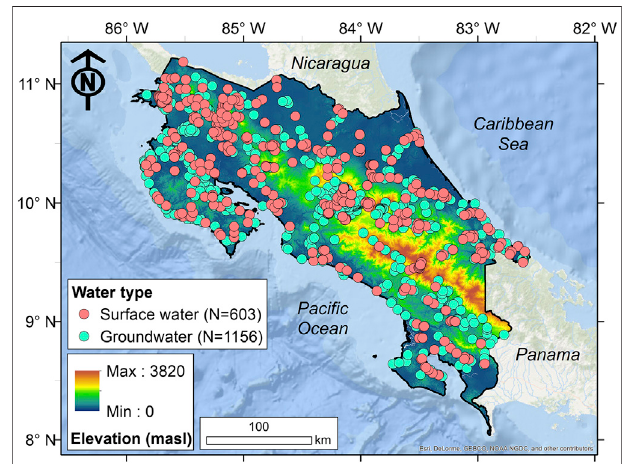
FIGURE 9 | Groundwater and surface water sampling sites across Costa Rica. Groundwater (cyan dots) and surface water (pink dots) samples collectedfrom2013to2019.FigureadaptedusingdatafromSánchez-Murillo and Birkel (2016).